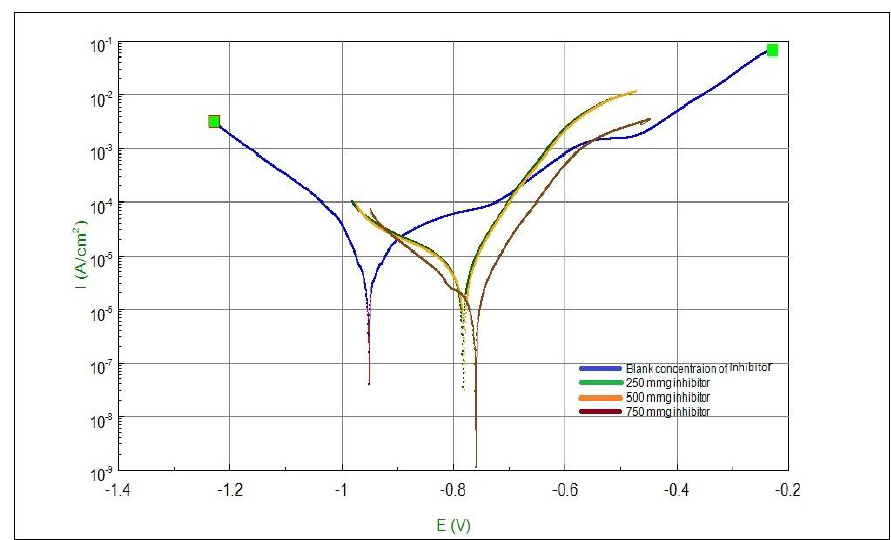
Fig. 3. Variation of inhibitor concentration on current density and voltage at 25 o C.